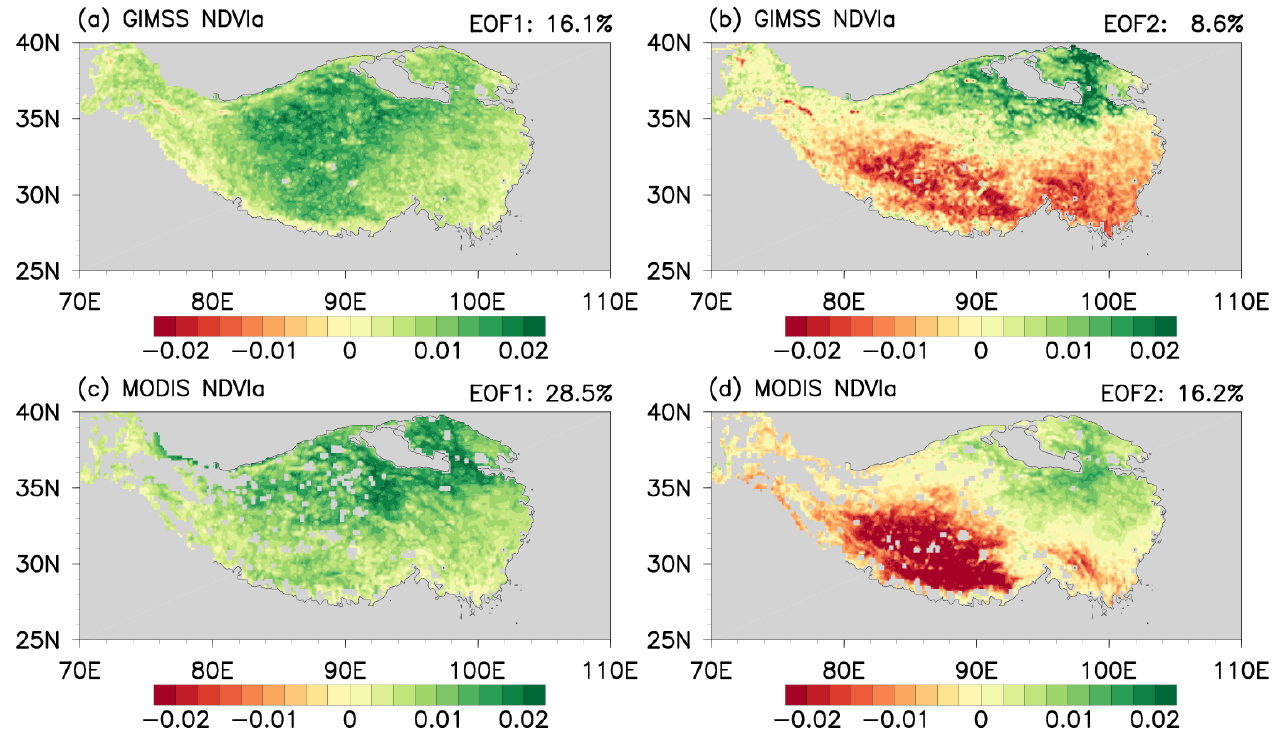
Figure 2. The first (EOF1; ( a )) and second (EOF2; ( b )) EOF modes of the JJAS standardized GIMMS NDVI anomalies over the TP during the period 2002–2014. ( c , d ) as in ( a , b ), respectively, but for the MODIS NDVI anomalies.